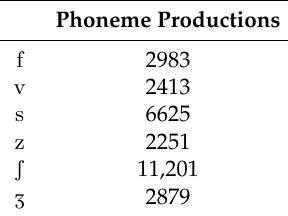
Table 5. Number of fricative phoneme productions used to train the classification